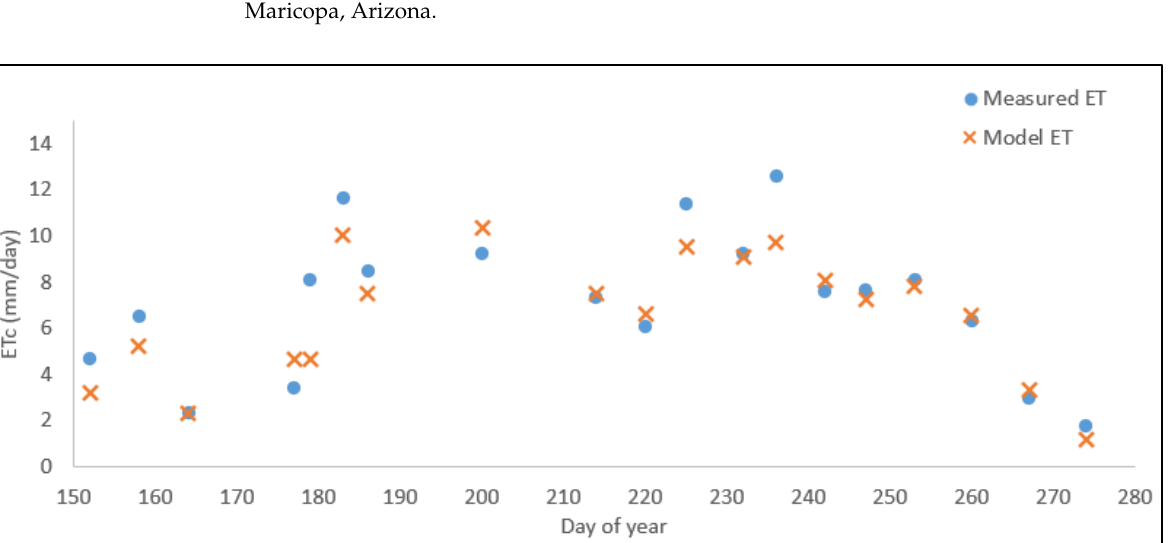
transpiration, and reference ET for the FT (FAO) treatment, plot 12, in the 2007 cotton experiment in